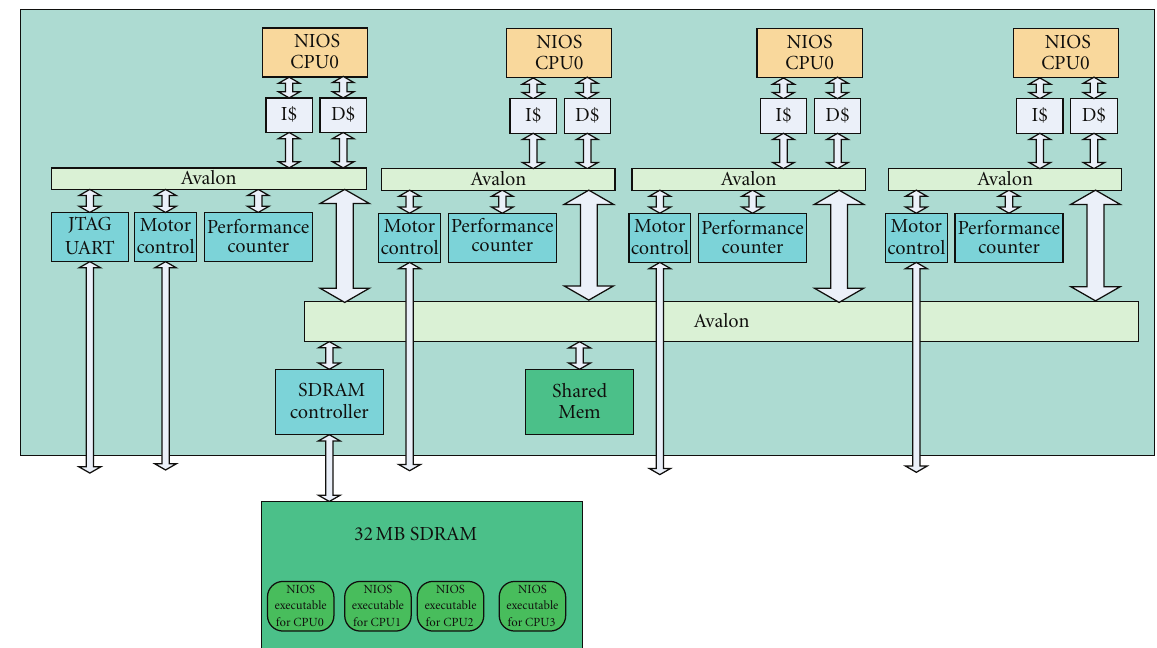
Figure 9: Multi-soft-core architecture on the Terasic DE0-Nano